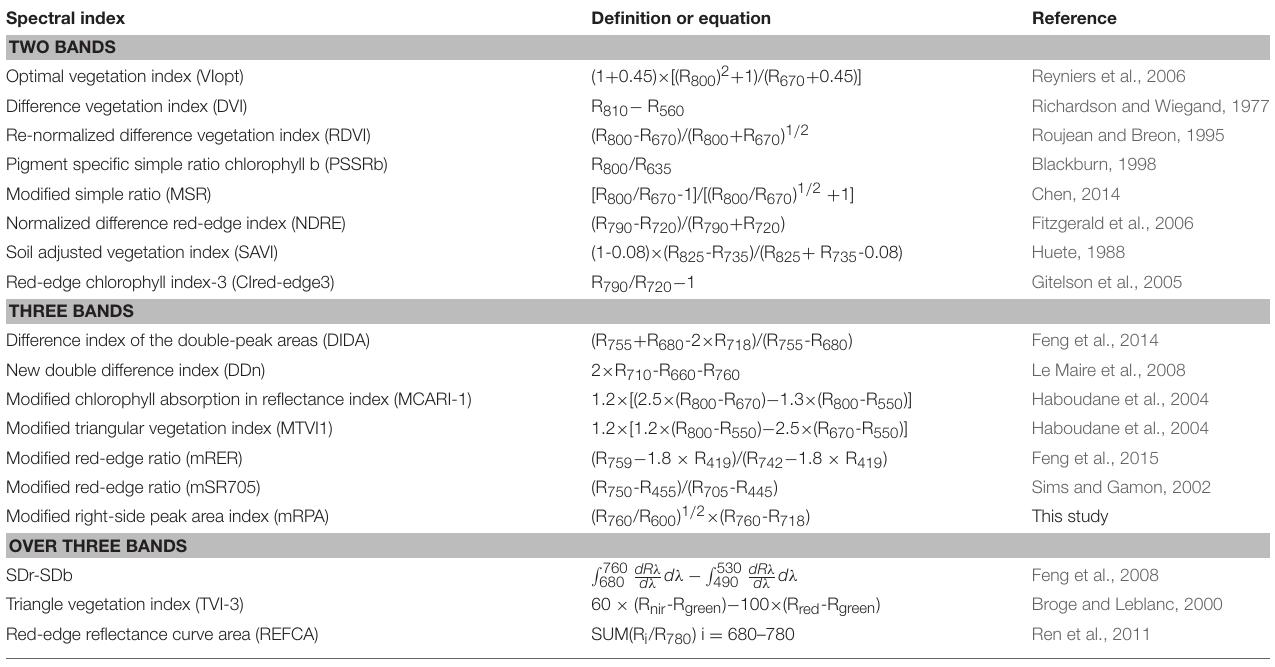
TABLE 2 | Summary of selected vegetation indices published in the